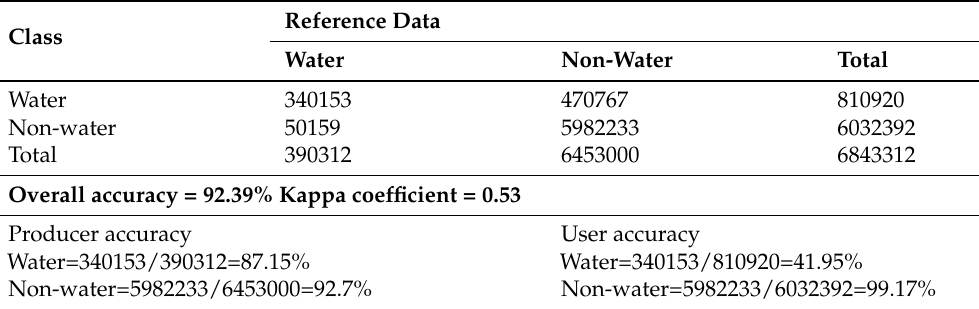
Table 4. Error matrix of the ALG2 classified image (Dataset